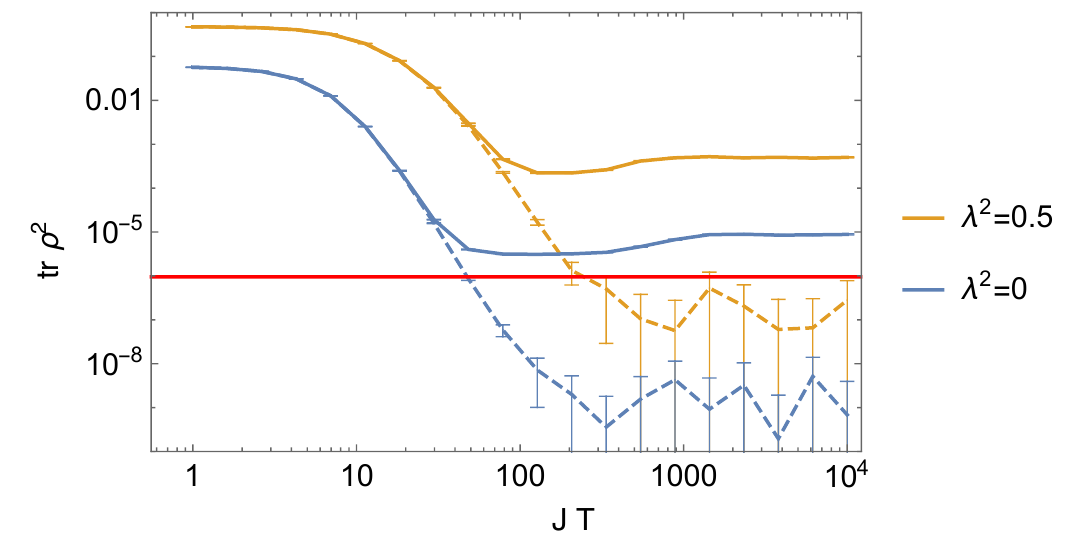
Figure 2 . The conditional Renyi ˜ R 2 as a function of Lorentzian time evolution JT , obtained by numerically diagonalizing the SYK Hamiltonian for N = 20 , βJ = 16 and n trials = 3000 . 1 σ error bars are displayed. The solid curve is the full answer while the dashed curve is the “disk” approximation ˜ R disk . We see that the disk approximation is good for early times, but decays too 2 rapidly at late times. Even without computing the full answer (in orange), the unitarity bound tr ρ 2 ≥ 2 − N would rule out the disk answer at large